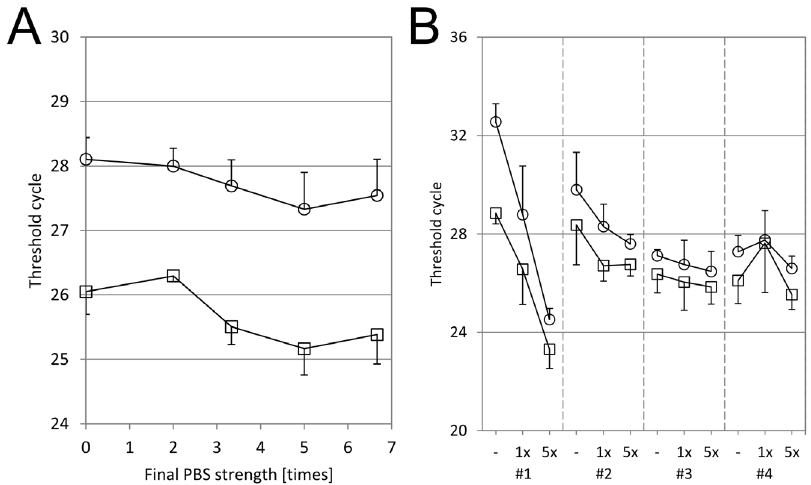
Figure 3. pH and Salt Concentration Adjustment for Efficient EMV Capture. A. Spot urine from a healthy donor was centrifuged at 800 6 g for 15 min and the supernatant was collected. Two mL of the supernatant was mixed with 0, 0.5, 1, 2 or 4 mL of 10 6 PBS, then applied to EMV capture devices. ACTB ( # ) and GAPDH ( % ) were quantified in triplicate as described in Materials and Methods. Mean Ct values were plotted and error bars are standard deviations. B. Twelve-hour urine samples were obtained from four healthy donors ( # 1 to # 4). The samples were centrifuged at 800 6 g for 15 min and the supernatants were collected. Four and a half mL of the supernatants were mixed with 0 mL (-), 0.5 mL (1 6 ) or 4.5 mL (5 6 ) of 10 6 PBS, then applied to EMV capture devices. GAPDH ( # ) and RPLP0 ( % ) were quantified in triplicate as described in Materials and Methods. Mean Ct values were plotted and error bars are standard deviations.